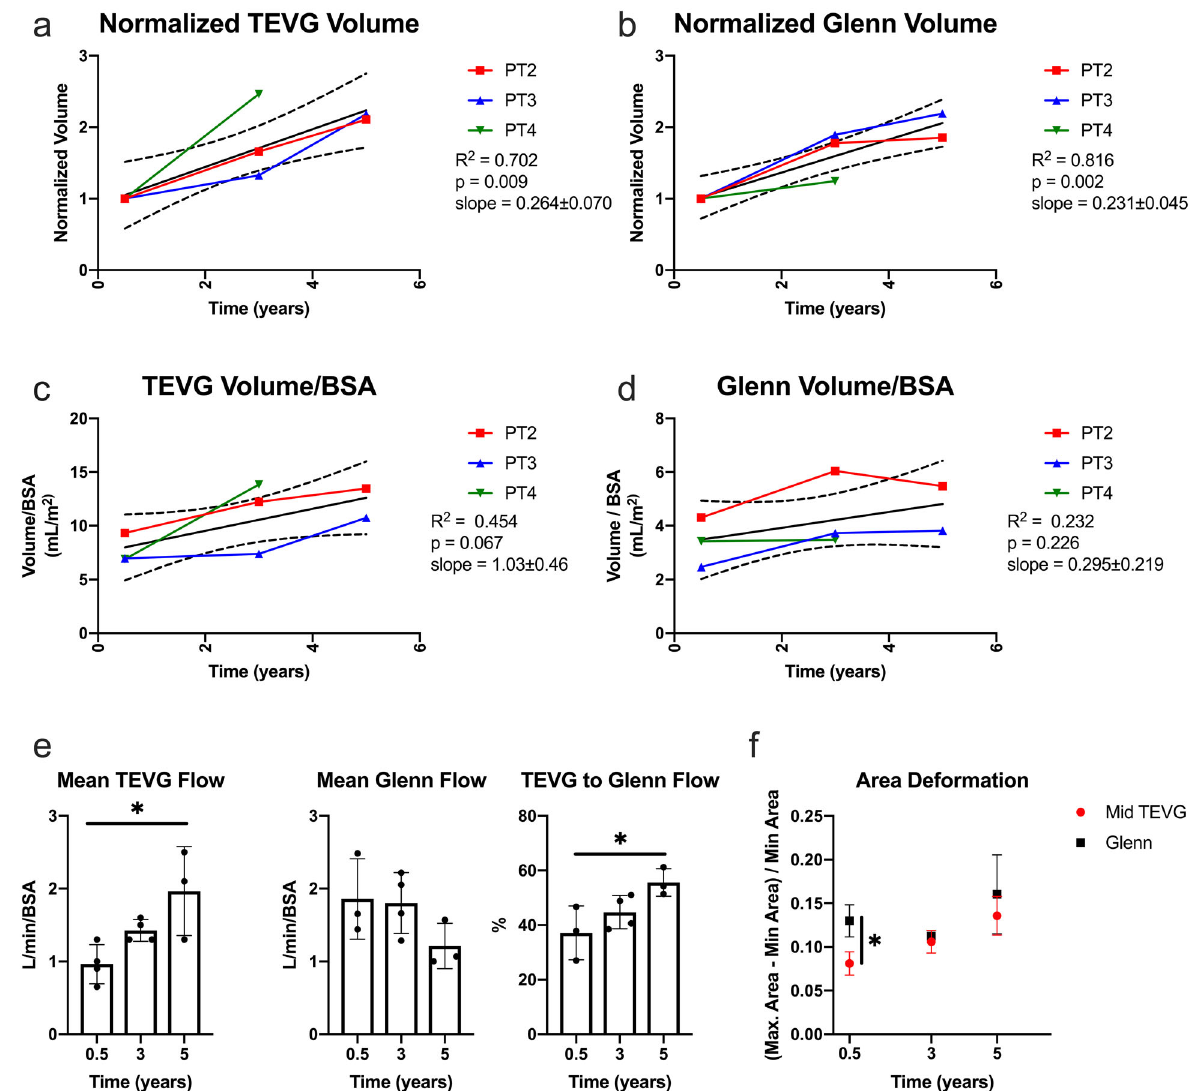
Fig. 3 TEVG growth analysis: serial MRI data from the clinical trial. a TEVG volume normalized to the size of the graft at 6 months. b Glenn volume normalized to the size of the vessel at 6 months. c Change in TEVG volume over time normalized to body surface area. d Change in Glenn volume over time normalized to body surface area. e Mean volumetric fl ow through the TEVG and Glenn normalized to body surface area. Error bars represent standard deviation. f Change in luminal cross-sectional over one cardiac cycle evaluated longitudinally by MRI. ( n = 4 at 0.5 and 3 year time points, n = 3 at 5 year time point) Error bars represent standard deviation. TEVG tissue-engineered vascular graft, Glenn superior vena cava to pulmonary artery connection, BSA body surface